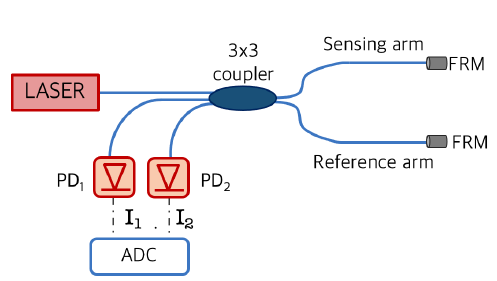
Figure 1. Michelson interferometer